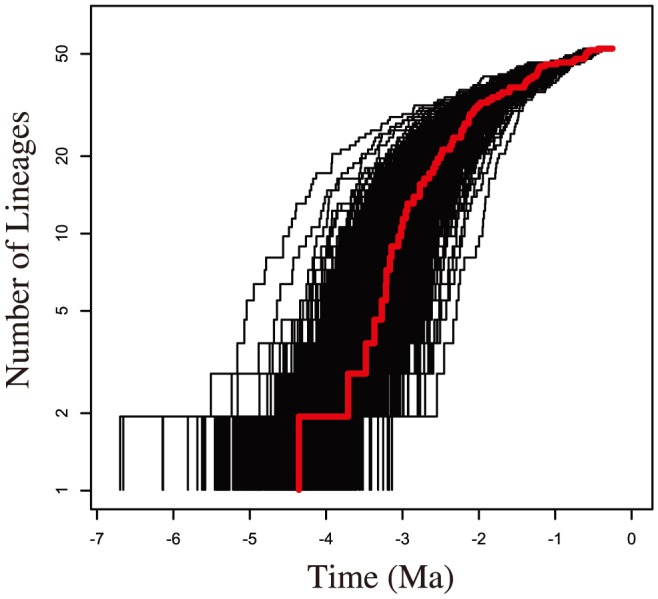
Lineage through time plot. Lineage through time plot of Maximum clade credibility tree in red.Lineage through time plot of 1000 post burn in topologies from the BEAST analysis in black.